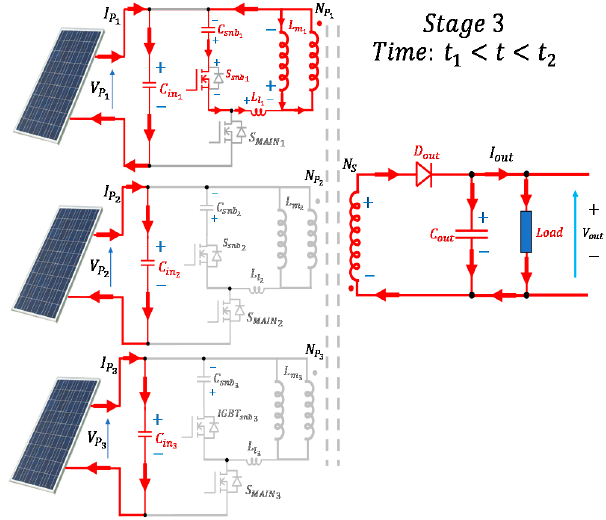
Figure 4. Stage 3, time: 𝑡 (cid:2869) < 𝑡 < 𝑡 (cid:2870) .